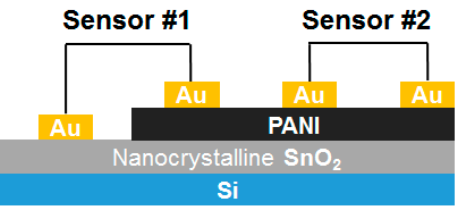
Figure 3. Schematic of the Si/SnO 2 -PANI heterostructure gas sensor with gold contacts [40].